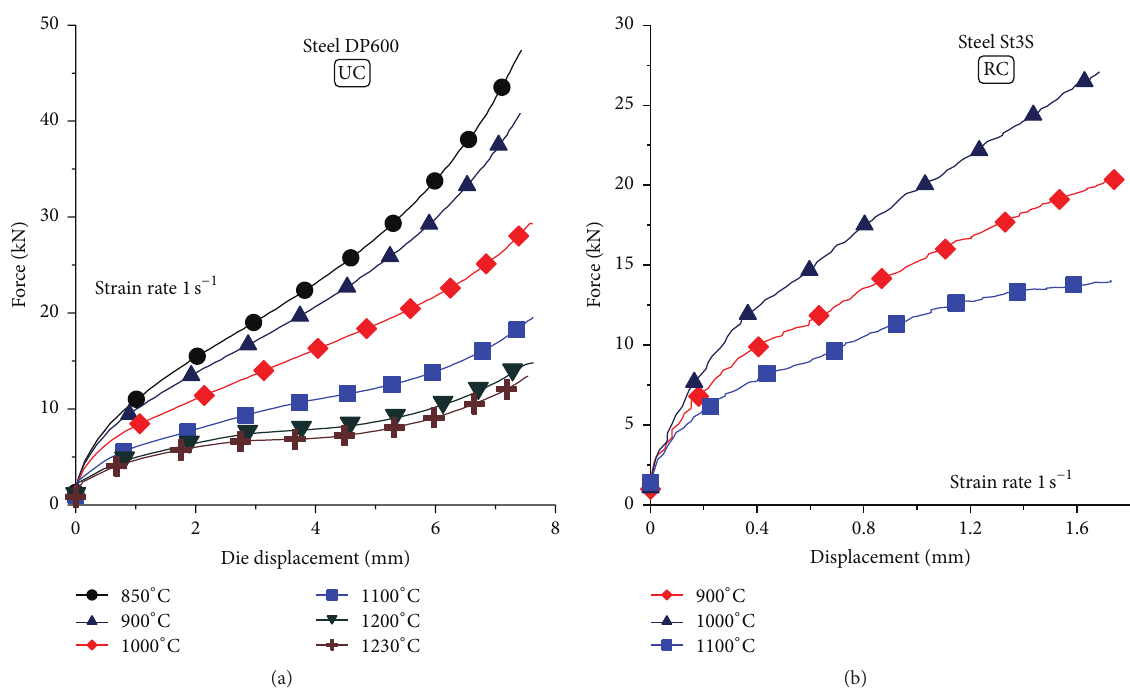
Figure 7: Loads measured in the UC tests for the DP600 steel, strain rate 1 s −1 (a), and for the RC tests for the St3S steel, strain rate 1s −1 (b).